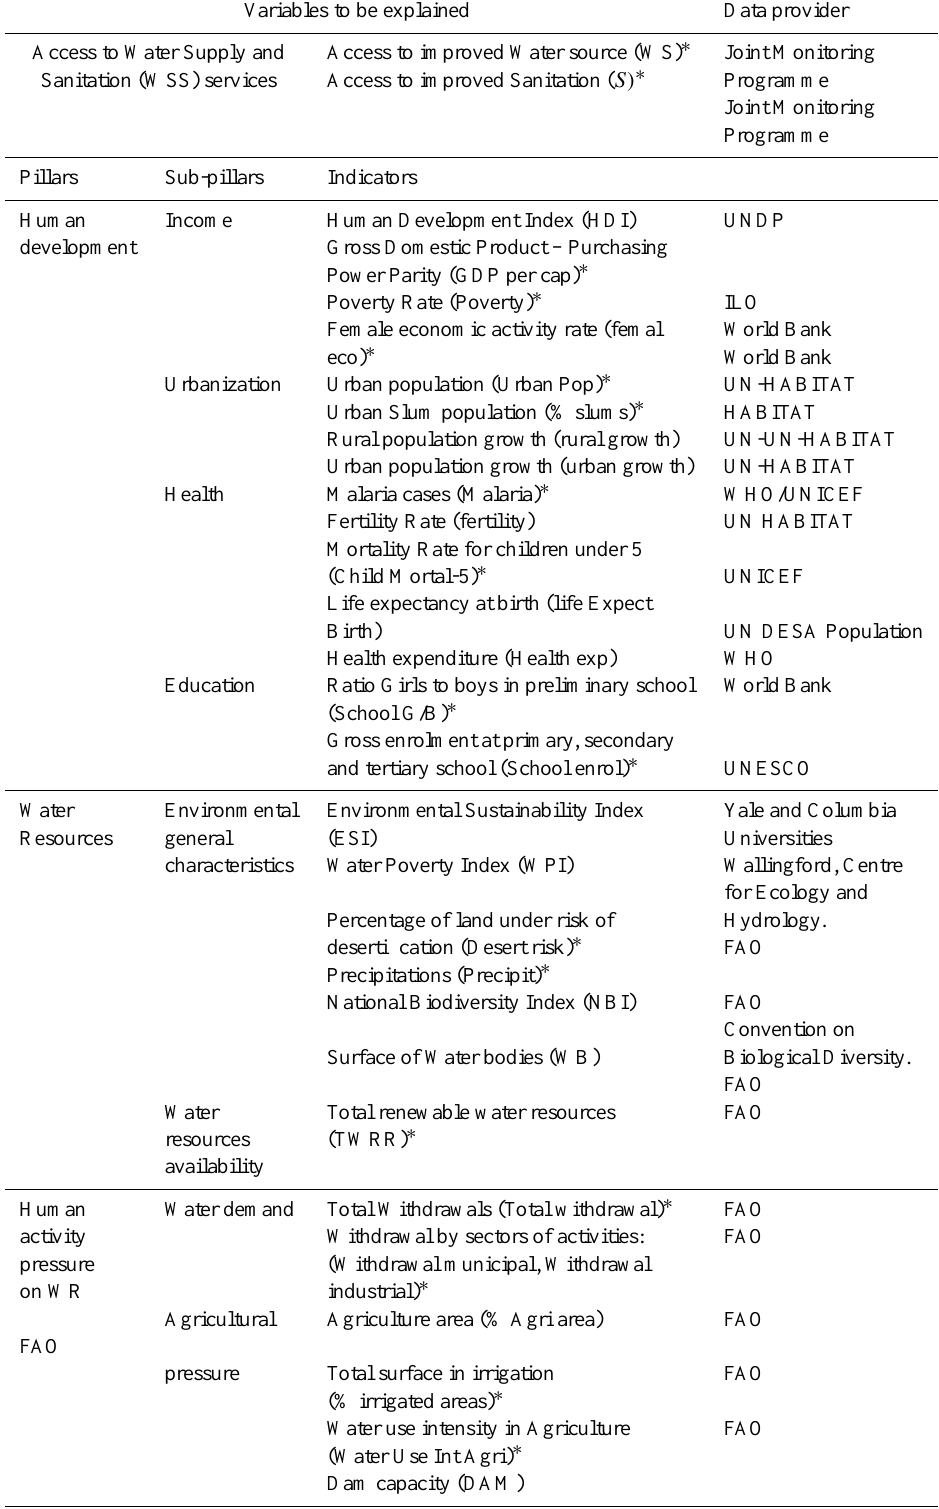
Table 1. Indicators-Variables integrated in the WatSan4Dev